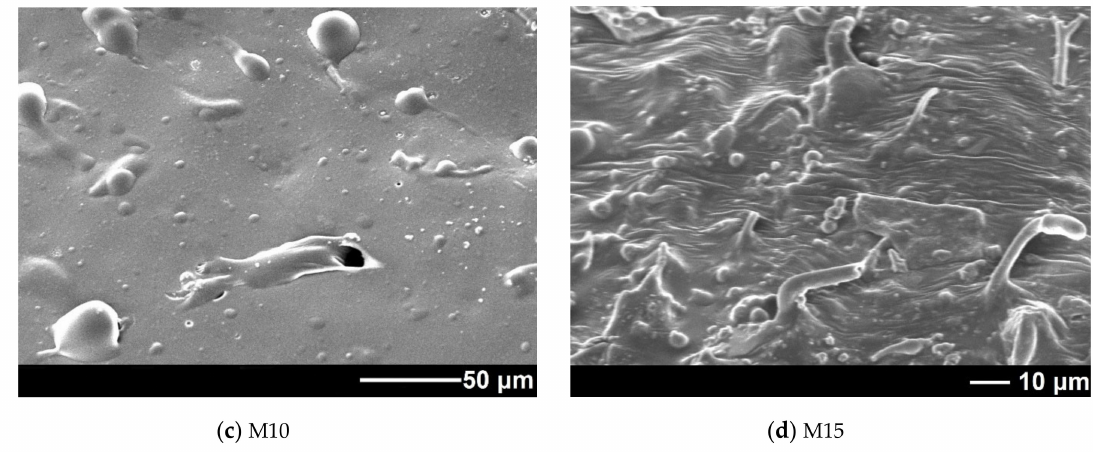
Figure 8. SEM images of cleavages. Samples M0 ( a ), M5 ( b ), M10 ( c ), M15 ( d ).